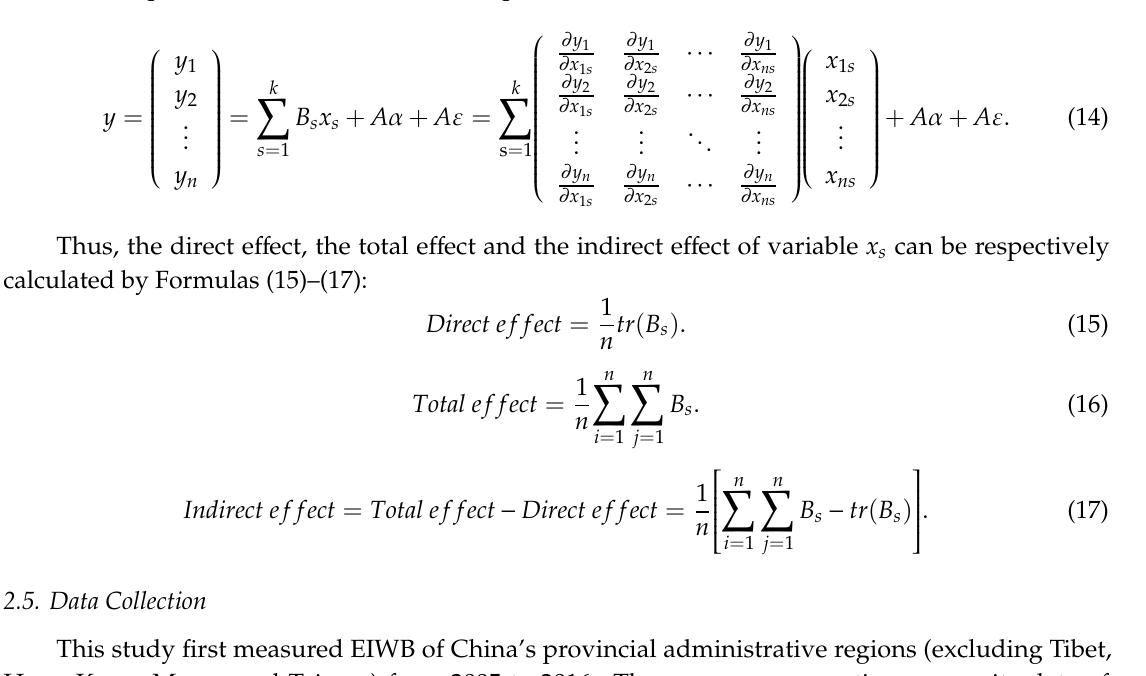
Figure 2. ( a ) Spatial distribution quartile maps of EIWB in 2006; ( b ) spatial distribution quartile maps of EIWB in 2011 and ( c ) spatial distribution quartile maps of EIWB in 2016. In spatial distribution maps above, shades of different regions reflect its grade of EIWB respectively. Darker color in a province indicates a higher grade of EIWB. In particular, blank areas are provinces with missing data. Except the blank areas, the provinces in China can be divided into four grades according to the color from dark to light. The first grade contains seven provinces with the highest EIWB in China, which are shown with the darkest colors in the figure. The second and third grades each include eight provinces. The remaining seven of the lightest areas are at the fourth grade. The spatial quartile maps show the agglomeration and heterogeneity of spatial distribution of EIWB. On the whole, the agglomeration of China’s EIWB was very obvious. The provinces with high EIWB mainly clustered in northern China, while the provinces with low EIWB were mainly concentrated in the southeast coastal areas. In 2006, the seven provinces with the highest EIWB were Liaoning, Inner Mongolia, Shanxi, Ningxia, Gansu, Qinghai and Xinjiang. In 2011 and 2016, the seven provinces with the highest EIWB were Tianjin, Liaoning and Inner Mongolia, Shanxi, Ningxia, Qinghai and Xinjiang. Comparing the spatial distribution of EIWB in these three years it could be found that EIWB of Liaoning, Inner Mongolia, Shanxi, Ningxia, Qinghai and Xinjiang were high, and Gansu’s EIWB fell from the first grade to the second grade during the inspection period. While Tianjin’s EIWB increased, becoming one of the new provinces with the highest grade of EIWB. Spatial distribution maps suggest that there might be a strong spatial autocorrelation of EIWB between all provinces in China, and the provinces with high EIWB mainly clustered in the northern part of China. Specially, Liaoning, Inner Mongolia, Shanxi, Ningxia, Qinghai or Xinjiang had high EIWB during the study period. The reason for this phenomenon might be that the per capita energy